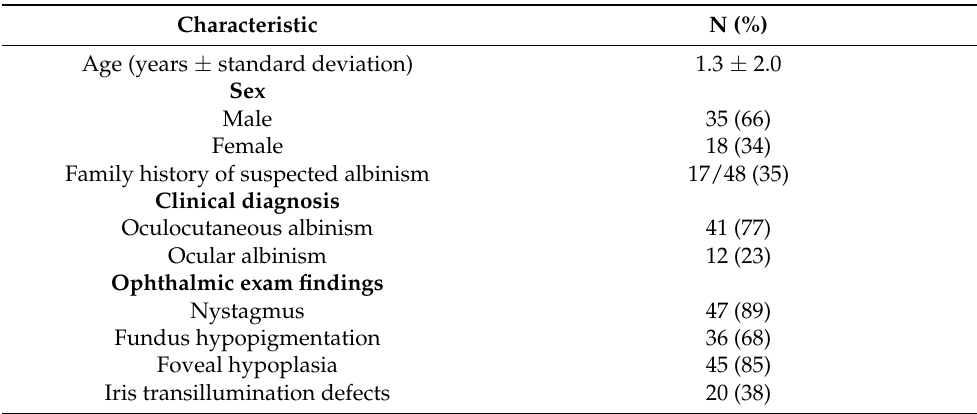
Table 1. Demographic and clinical characteristics of the 53 patients evaluated for OA/OCA with reviewable genetic testing